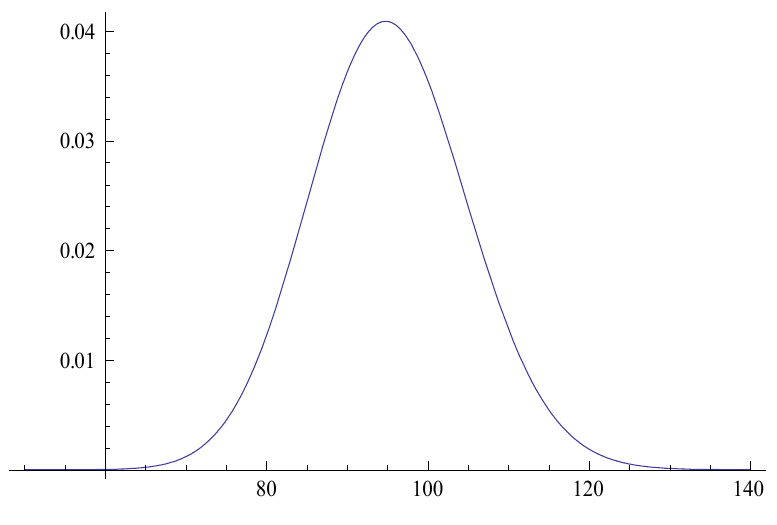
Figure 1. Probability of the number of meetings.